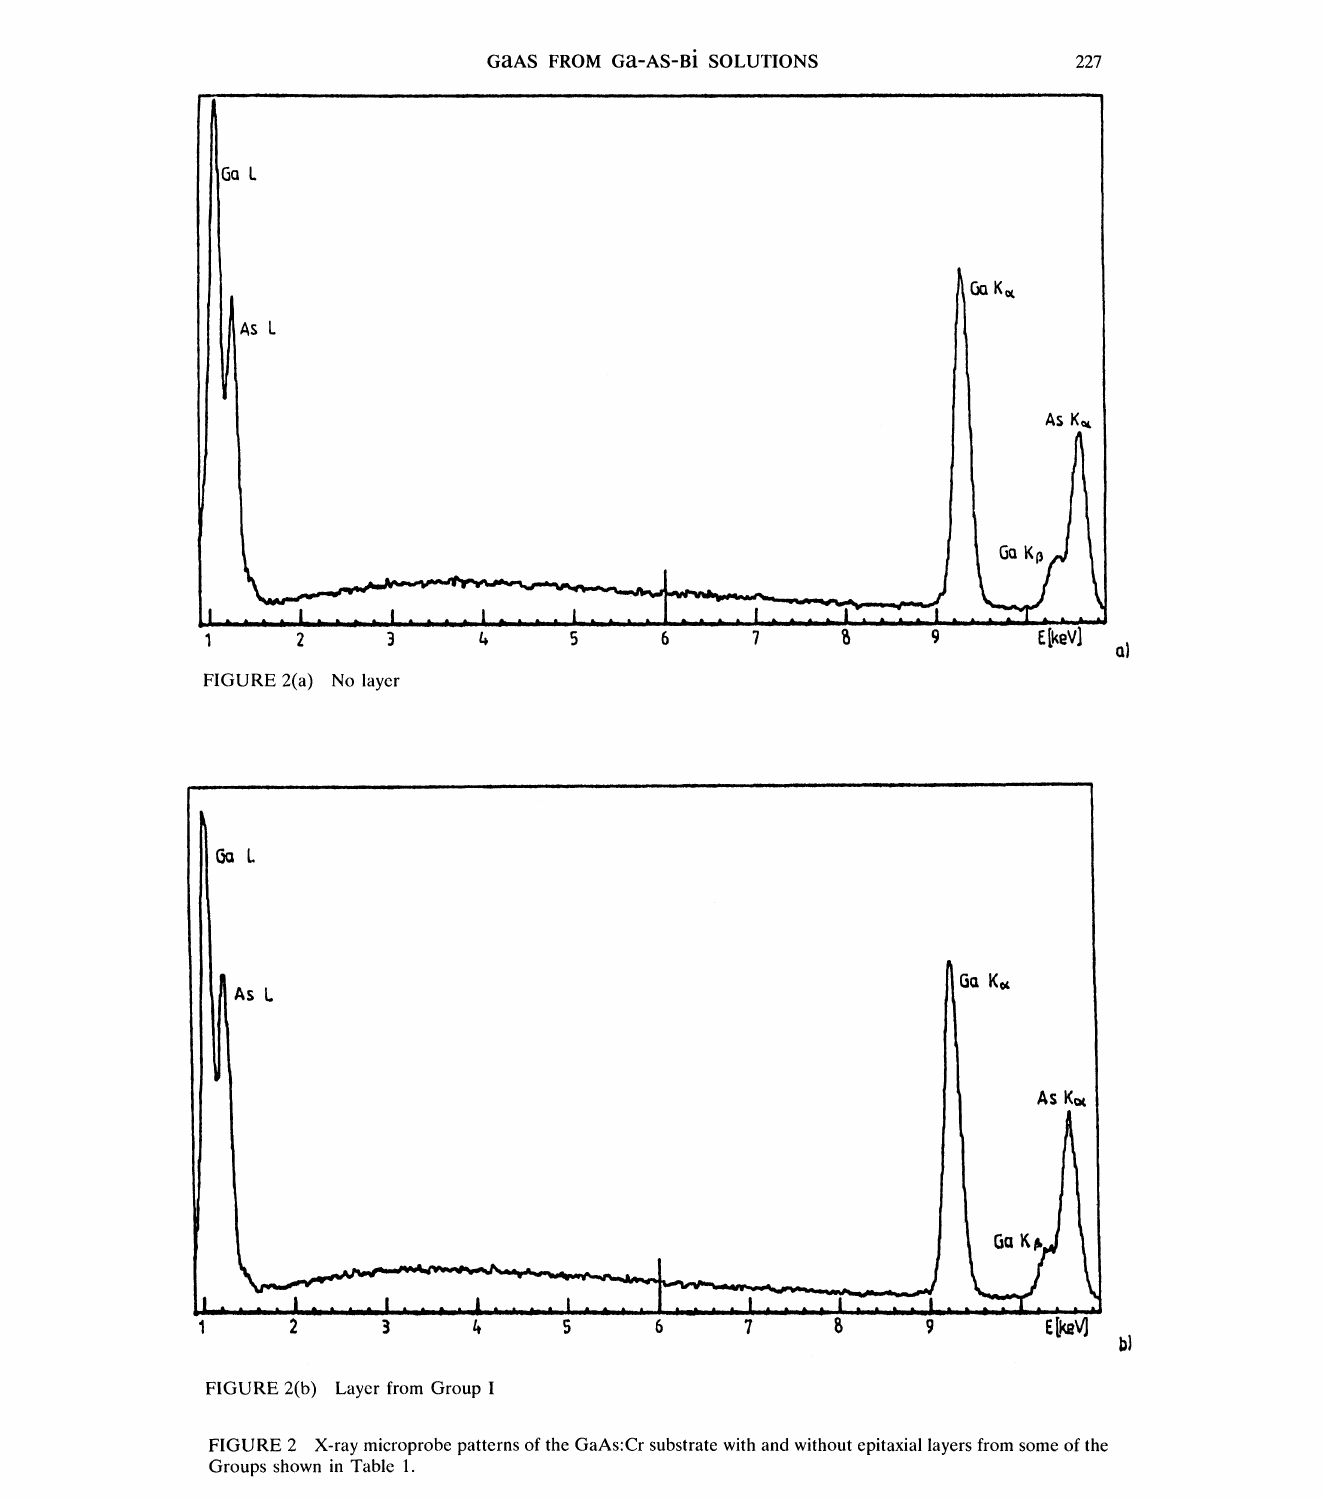
FIGURE 2 X-ray microprobe patterns of the GaAs:Cr substrate with and without epitaxial layers from some of the Groups shown in Table